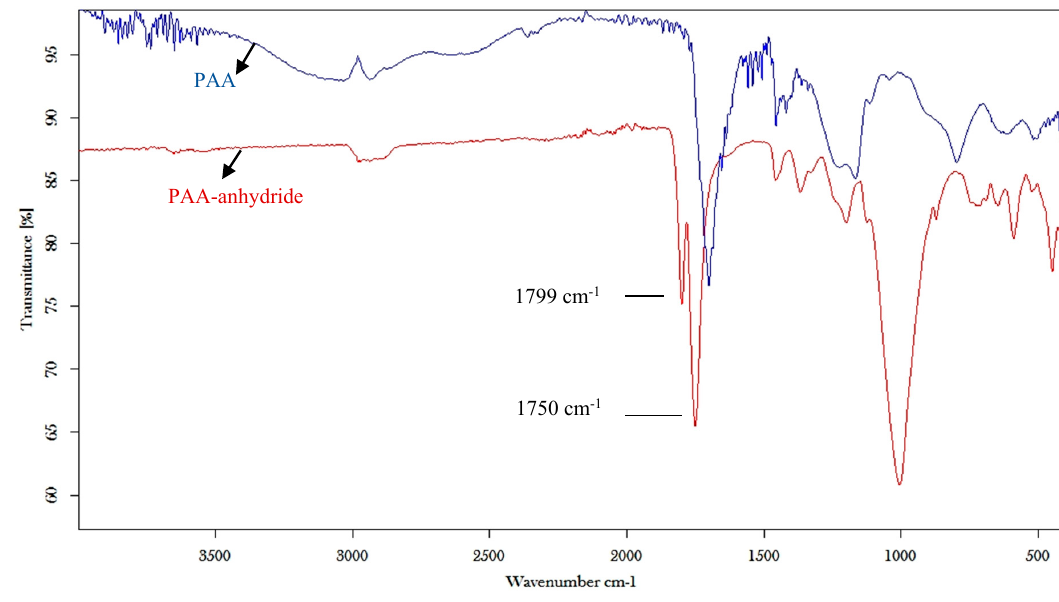
Figure 3. FT-IR spectroscopy of PAA and PAA anhydride.